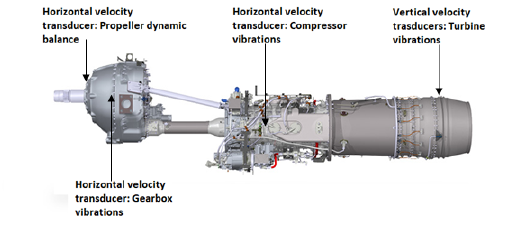
Figure 3. Locations of velocity